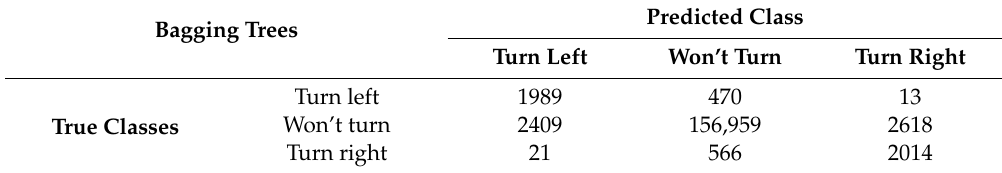
Table 8. The confusion matrix of the bagging trees with 0.1 s prediction time.